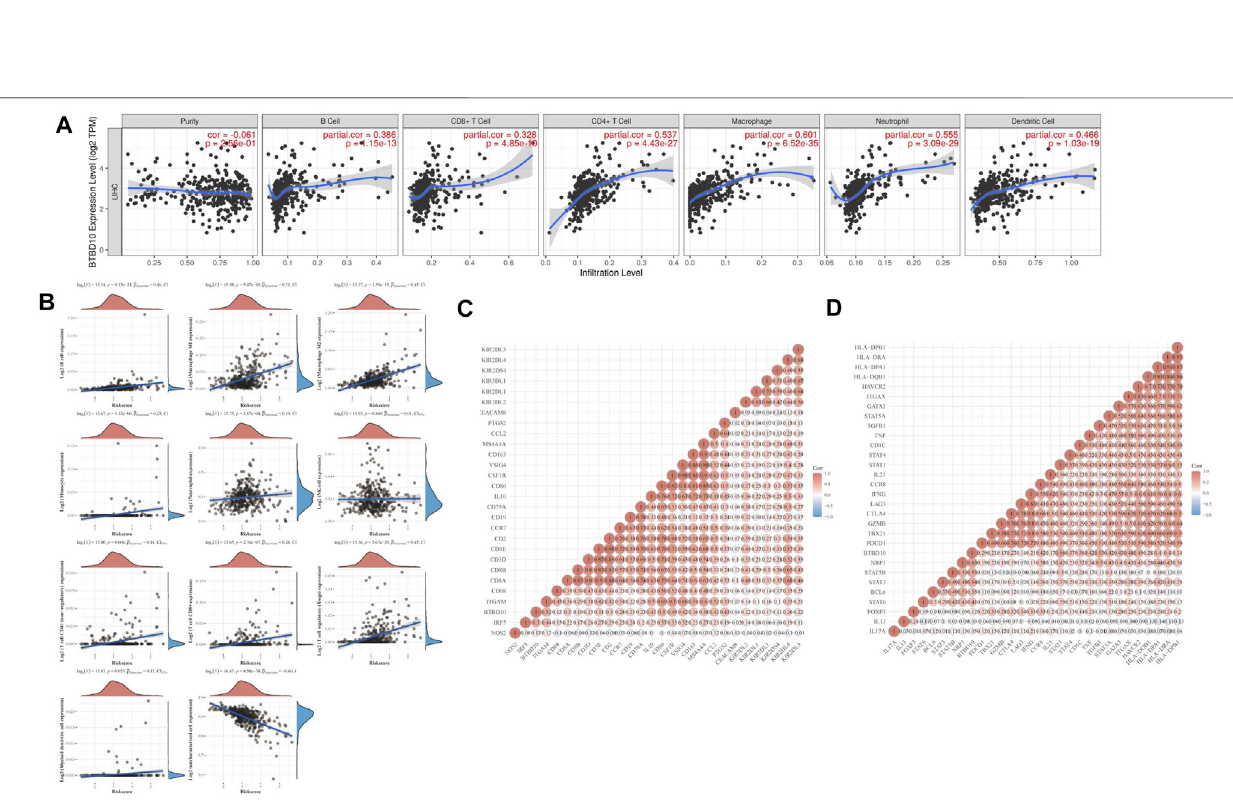
FIGURE 6 | Correlation analysis between BTBD10 expression and levels of in fi ltrating immune cells in HCC. (A) From the TIMER website; (B) TCGA data from ACLBI website; (C,D) A Heatmap of the correlation between BTBD10 and surface molecules of tumor-in fi ltrating lymphocytes (in the diagram, red represents positive correlation, blue represents negative